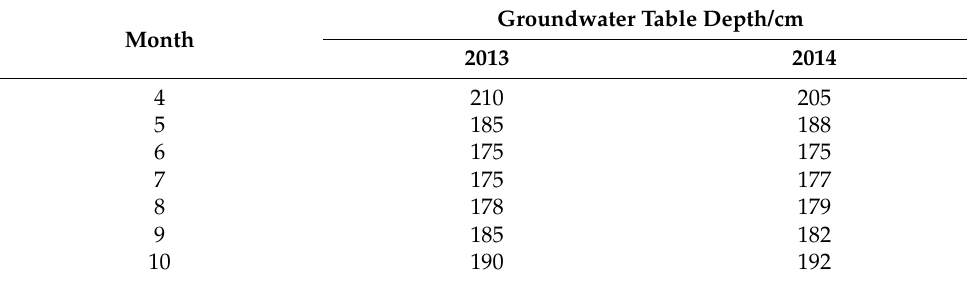
Table 2. Monthly groundwater levels for the irrigation season in the year 2013–2014.